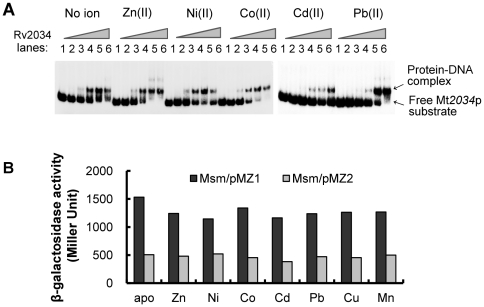
The effects of metal ions on the DNA-binding activity of Rv2034.(A) EMSA assays with or without metal ions. The Rv2034p DNA substrate was incubated with various amounts of the Rv2034 protein (0, 0.1, 0.2, 0.3, 0.4, and 0.5 µM) with or without 1 mM metal ions, as indicted on the top. (B) β-galactosidase activity was measured in M. smegmatis mc2 155 containing the pMZ1 and pMZ2 reporter plasmids. Cells were cultured with no metal supplement or maximum permissive concentrations of Zn(II) (70 µM), Ni(II) (35 µM), Co(II) (15 µM), Cd(II) (75 µM), Pb(II) (10 µM), Cu(II) (50 µM), or Mn(II) (0.75 µM).